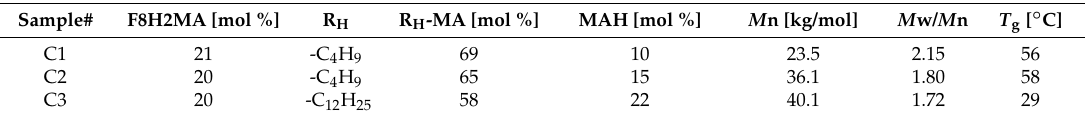
Table 1. Characteristics of the investigated terpolymers.